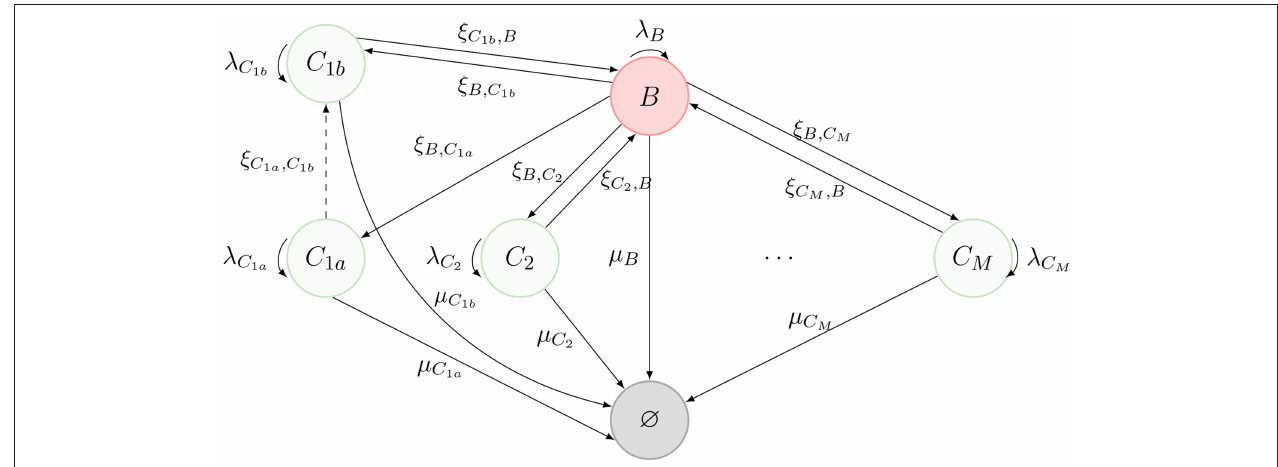
FIGURE 3 | New process inspired by Ganusov and Auerbach (3, Figure 2), where T cells can migrate between two compartments ( C 1 a and C 1 b ) without transitioning through the blood.